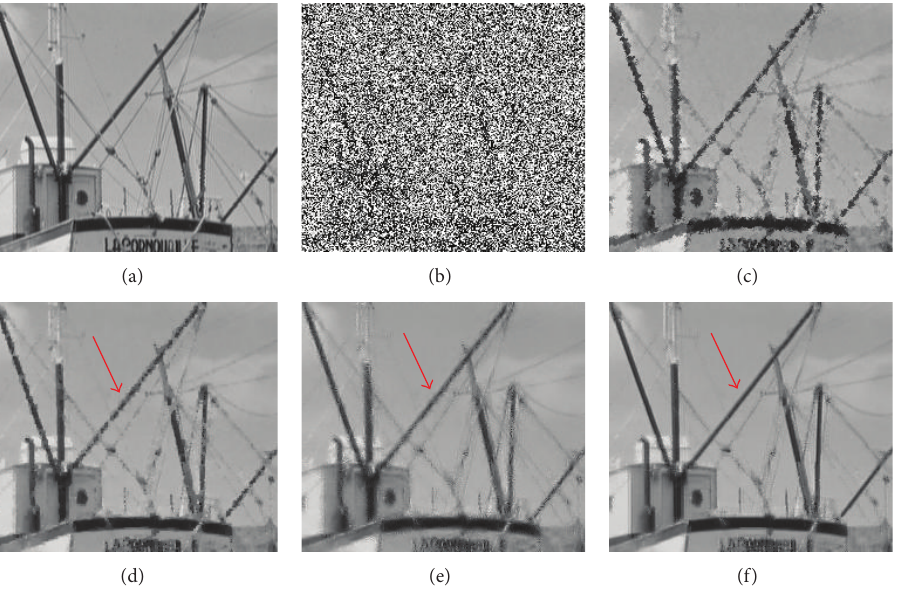
Figure 10: Reconstructed Boat images from 70% salt and pepper impulse noise. (a) Noise-free image, (b) noisy image, (c)–(f) reconstructed images using AMF, TV-ND, Wavelet-ND, and PANO-ND,